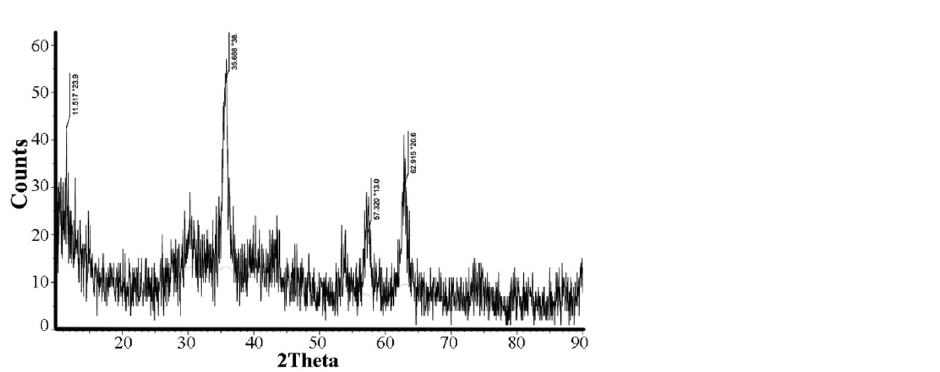
Figure 1. ( a ) FT-IR spectrum of Fe 3 O 4 (blue) m FuVe NPs (black) Pd@m FuVe NPs catalyst (red); and ( b ) VSM graph of Fe